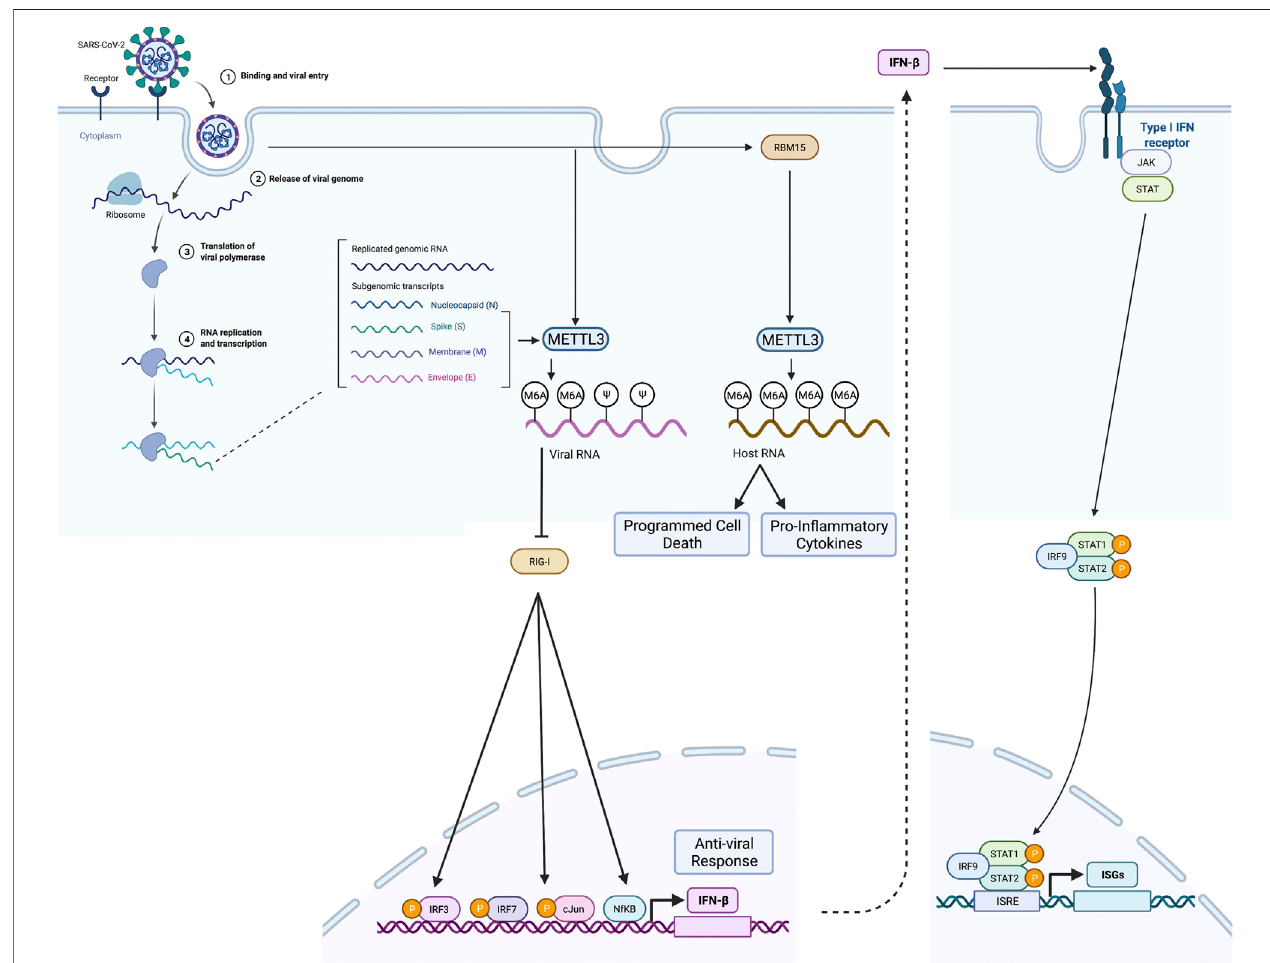
FIGURE 3 | m6A modi fi cation in SARS-CoV-2 RNA and cellular mRNA by METLL3 and RBM15, respectively, and its effect on evasion of host innate immune response by SARS-CoV-2 and host cell. (Left) After entering the host cell, the viral genome enters the replication phase, and METTL3 introduces m6A residues in viral RNA. m6A methylated SARS-CoV-2 does not bind RIG-I and induces the expression of antiviral molecules such as IFN β . Viral infection also enhances METTL3 and RBM15, leading to enhanced host mRNA m6A methylation resulting in activation of in fl ammatory gene expression and programmed cell death. (Right) When antiviral molecules such as IFN β levels increase, it leads to activation JAK-STAT pathway and interferon-stimulated gene (ISG) expression. Created with BioRender.